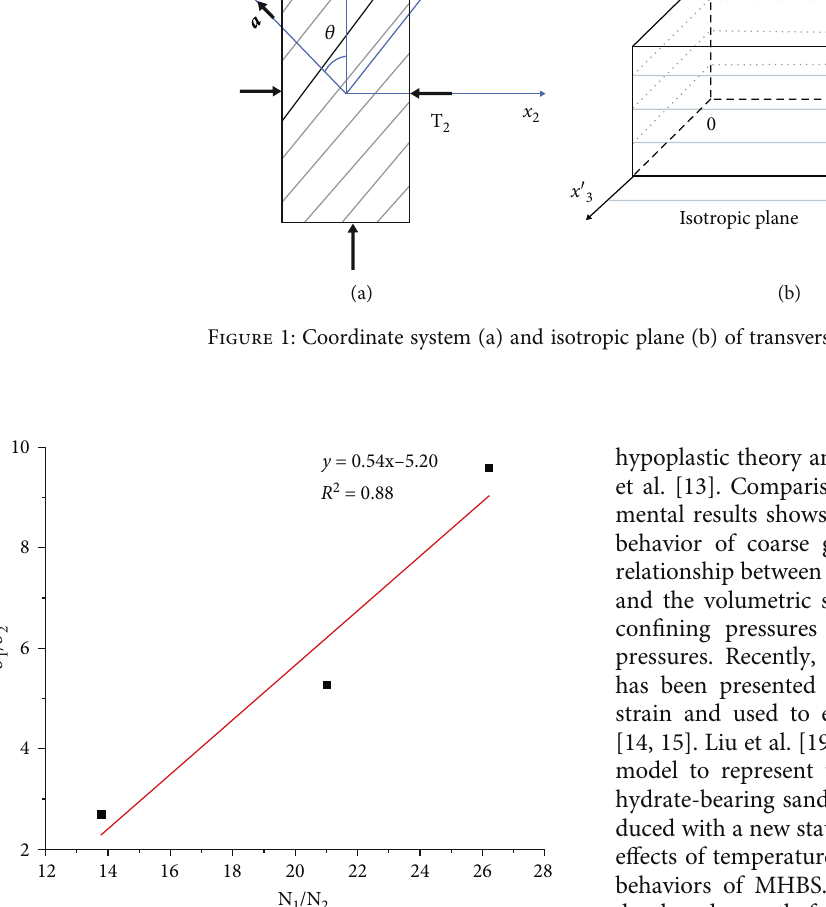
Figure 2: Stress ratio-anisotropy index curve ( θ =0 ° ) ( ∗ N anisotropy index related to the distribution of contact normal. N 1 and N 2 are the maximum and minimum densities of contact normal,